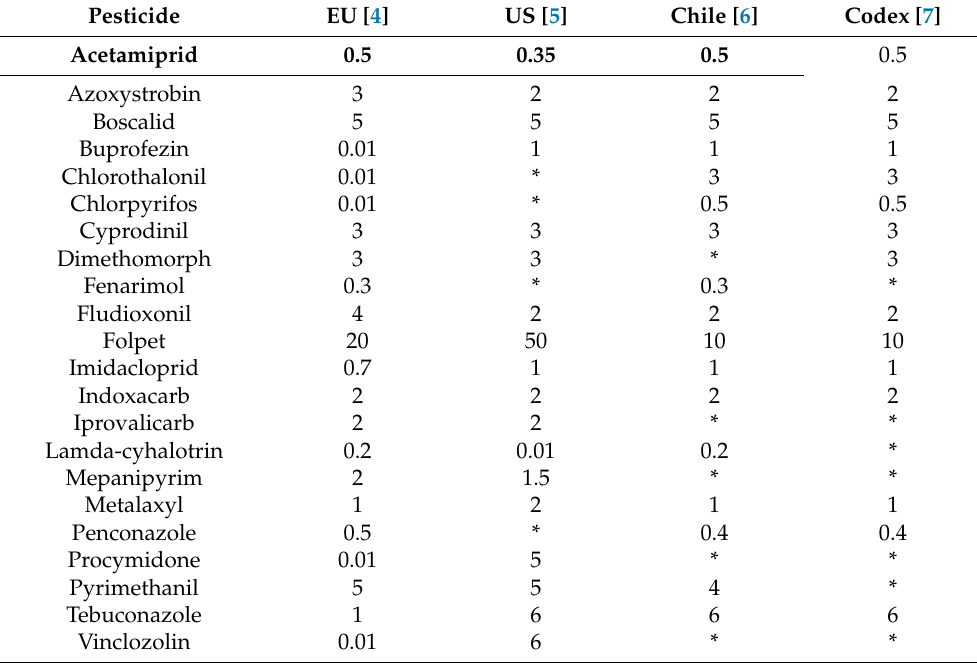
Table 1. Maximum residue limit in wine grapes for different pesticides in mg/kg. Pesticide EU